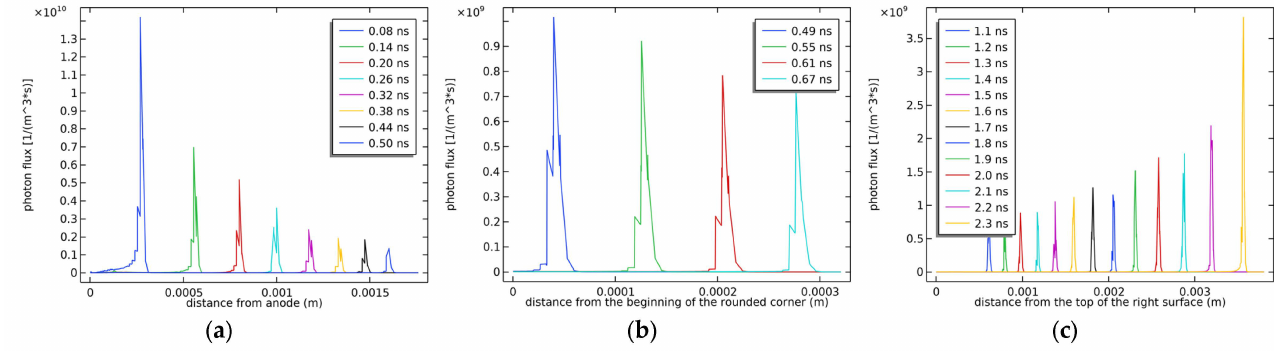
Figure 6. Variation in photon flux of the streamer head. ( a ) Stage 1 ( b ) Stage 2 ( c ) Stage